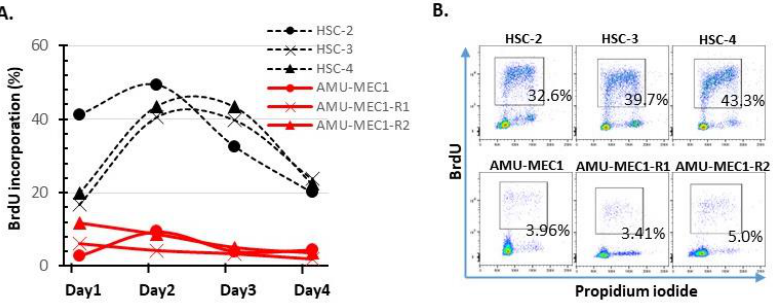
Figure 4. Comparison of BrdU incorporation between MEC and OSCC cell lines. On days 1–4, following cell replating, BrdU incorporation was analyzed using flow cytometry. ( A ) Change in BrdU incorporation (%) in each cell. The red and black dotted lines indicate MEC and OSCC cell lines, respectively. ( B ) Representative cytograms analyzed on day 3. The upper and lower column indicate OSCC and MEC cell lines, respectively.